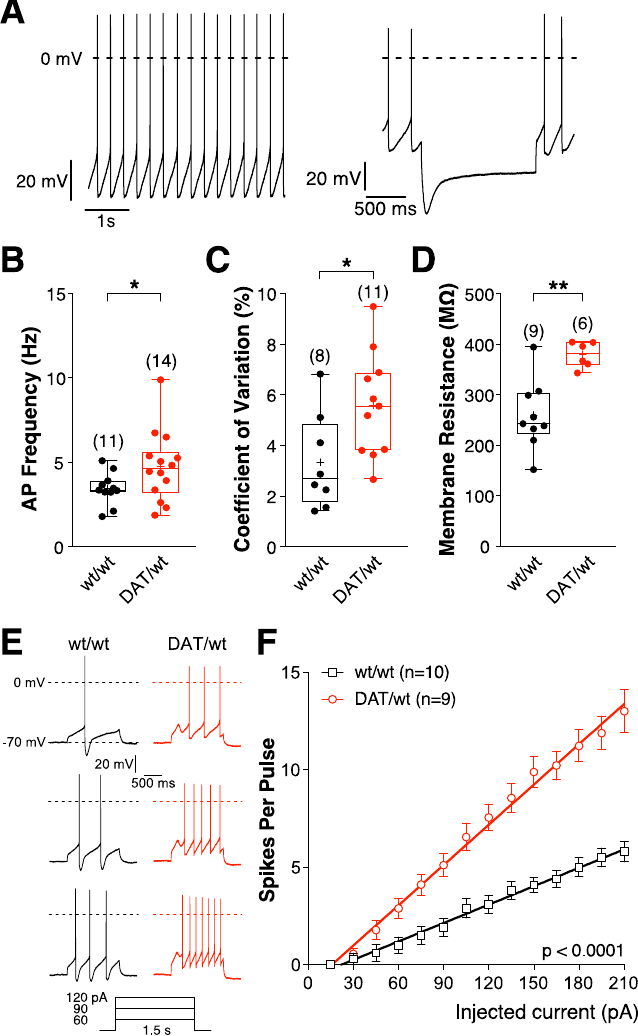
Figure 2. Intrinsic electrophysiological properties of SNc DA neurons are changed in Dnmt3a2/3L Dat / wt mice. ( A – F ) Electrophysiological parameters of SNc DA neurons in Dnmt3a2/3L Dat / wt and Dnmt3a2/3L wt / wt mice. Current clamp recordings were performed in the perforated patch clamp configuration. ( A ) DA neurons in the SNc were identified by their slow and regular firing (left) and the presence of a large I H (hyperpolarization-activated cation current)-dependent ‘sag’ potential (right). ( B ) Spontaneous activity. ( C ) Coefficiant of variation. ( D ) Cell input resistance. * p < 0.05, ** p < 0.01. p -values are for Welch’s unpaired Student’s t -tests ( B , D ) or unpaired t -tests ( C ). Excitability of DA neurons in Dnmt3a2/3L Dat / wt and Dnmt3a2/3L wt / wt mice. ( E ) Representative voltage responses to depolarizing current pulses. ( F ) Mean spike counts during current pulses (1.5 s) as a function of injected current from a holding potential of − 70 mV. Mean values are represented as mean ± SEM. F(1,24) = 468.7; p < 0.0001.